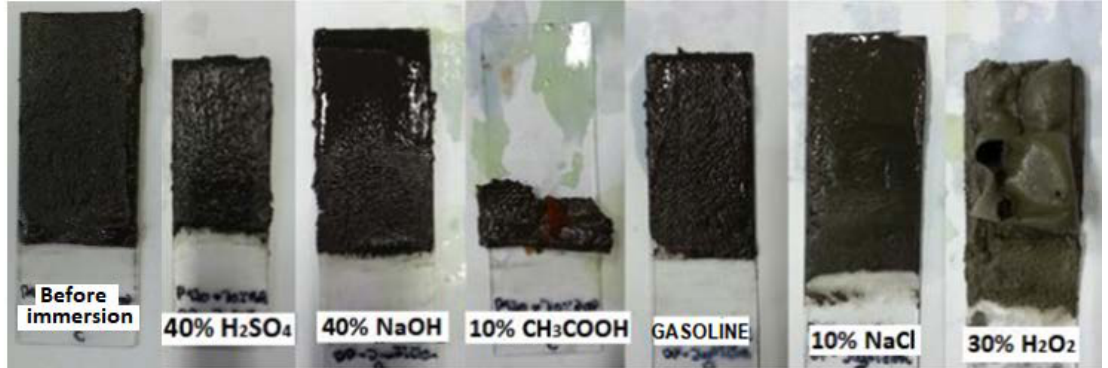
Figure 14. Samples of epoxy composites composed of the fly ash (FA) and the ER2 polymeric matrix after 28 days of exposure to various chemically aggressive environments.